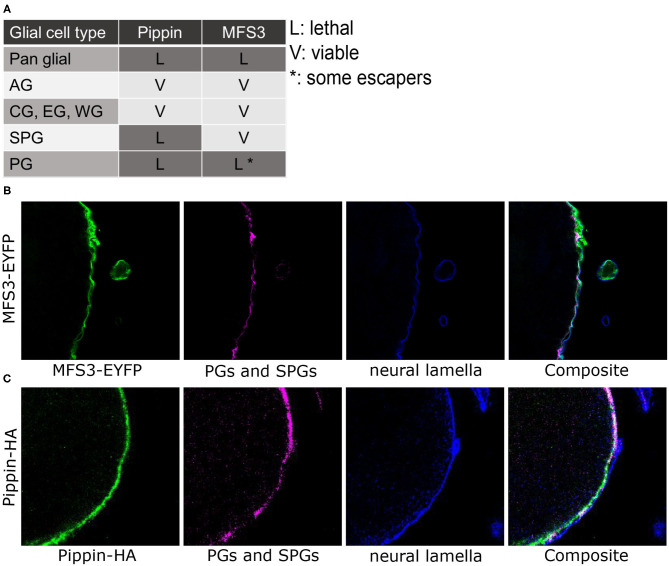
CG4797 (pippin) and Mfs3 encode putative BBB carbohydrate transporters. (A) RNAi interference-mediated silencing of pippin (using CG4797dsRNA10598) and Mfs3 Mfs3dsRNA4726R-3 in selected glial subtypes using glial subtype-specific Gal4 driver lines (pan glial: repo-Gal4; astrocyte-like glial cells (AG): alrm-Gal4; cortex glia (CG), ensheathing glia (EG), and wrapping glia (WG): nrv2-Gal4; subperineurial glial cells (SPG): Gli-Gal4, moody-Gal4; perineurial glial cells (PG): apt-Gal4, 46F-Gal4). Lethality was observed upon panglial and perineurial glia-specific suppression of pippin and Mfs3. In addition, lethality also occurred upon subperineurial glia-specific silencing of pippin. (B) Immunofluorescence staining of a transgenic Pippin-HA adult brain [green: Pippin-HA, magenta: NC120 (PGs and SPGs), blue: laminin (neural lamella)]. Pippin is found in subperineurial and perineurial glial cells. (C) Immunofluorescence staining of an MFS3-EYFP expressing adult brain [green: MFS3-EYFP, magenta: NC120 (PGs and SPGs), blue: laminin (neural lamella)]. MFS3-EYFP is expressed in the perineurial glial cells.